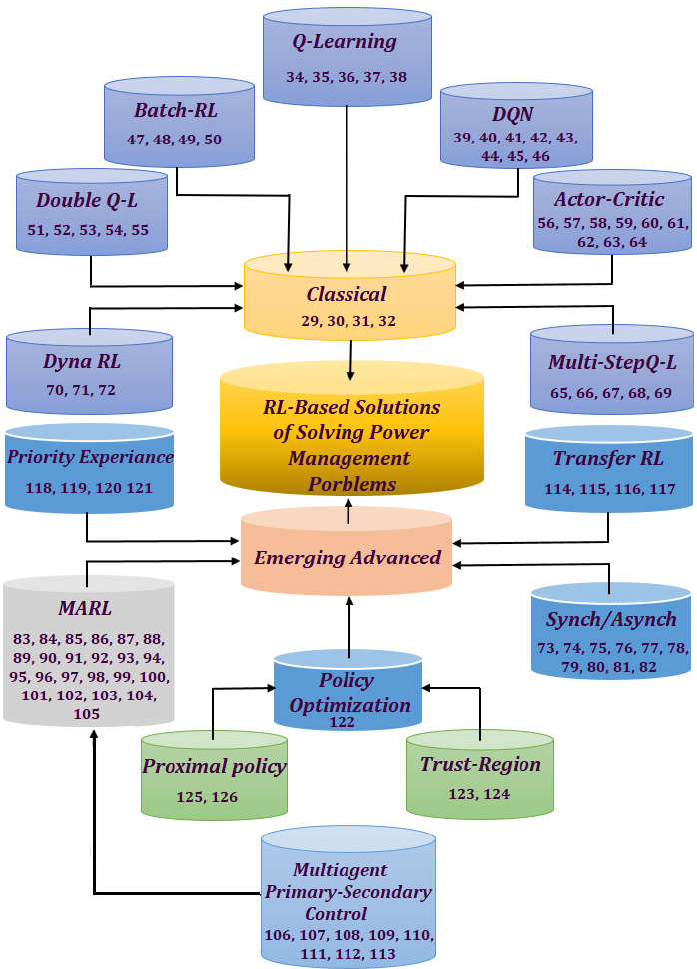
Figure 1. RL-based solutions for solving power management problems with the relevant reviewed research works.